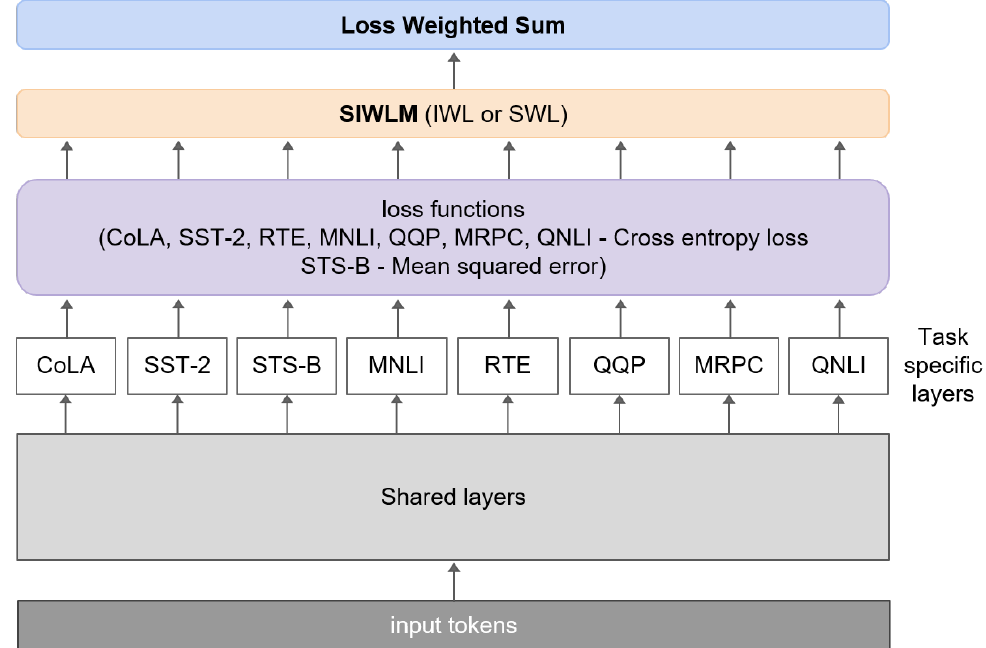
Figure 1. Model architecture used to apply the sequential and intensive weighted language modeling (SIWLM) scheme to MTL.